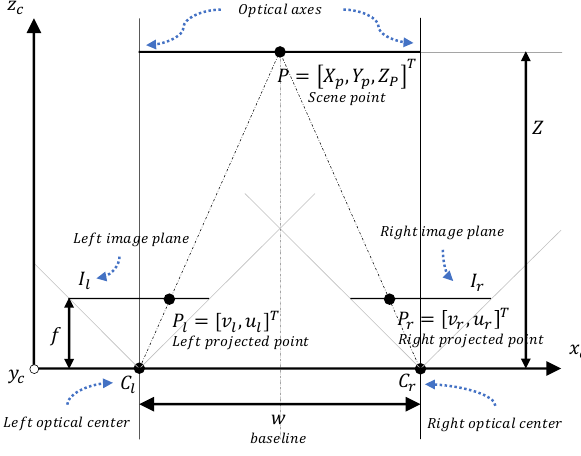
𝑅𝑅𝑏𝑏𝑅𝑅𝑅𝑝𝑝𝑝𝑝𝑝𝑝𝑝𝑝𝑏𝑏𝑆𝑆𝑏𝑏𝑏𝑏𝑆𝑆𝑏𝑏𝑏𝑏𝑝𝑝𝑏𝑏𝑝𝑝